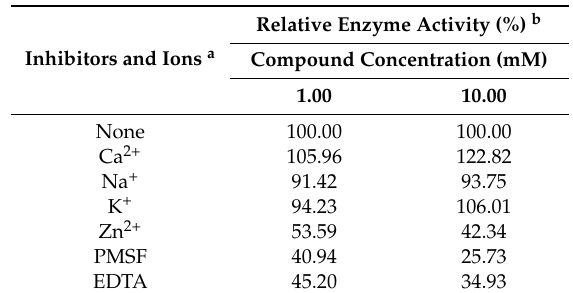
Table 3. Influence of various concentrations of metal ions and inhibitors on the crude CEP activity of L. plantarum LP69.